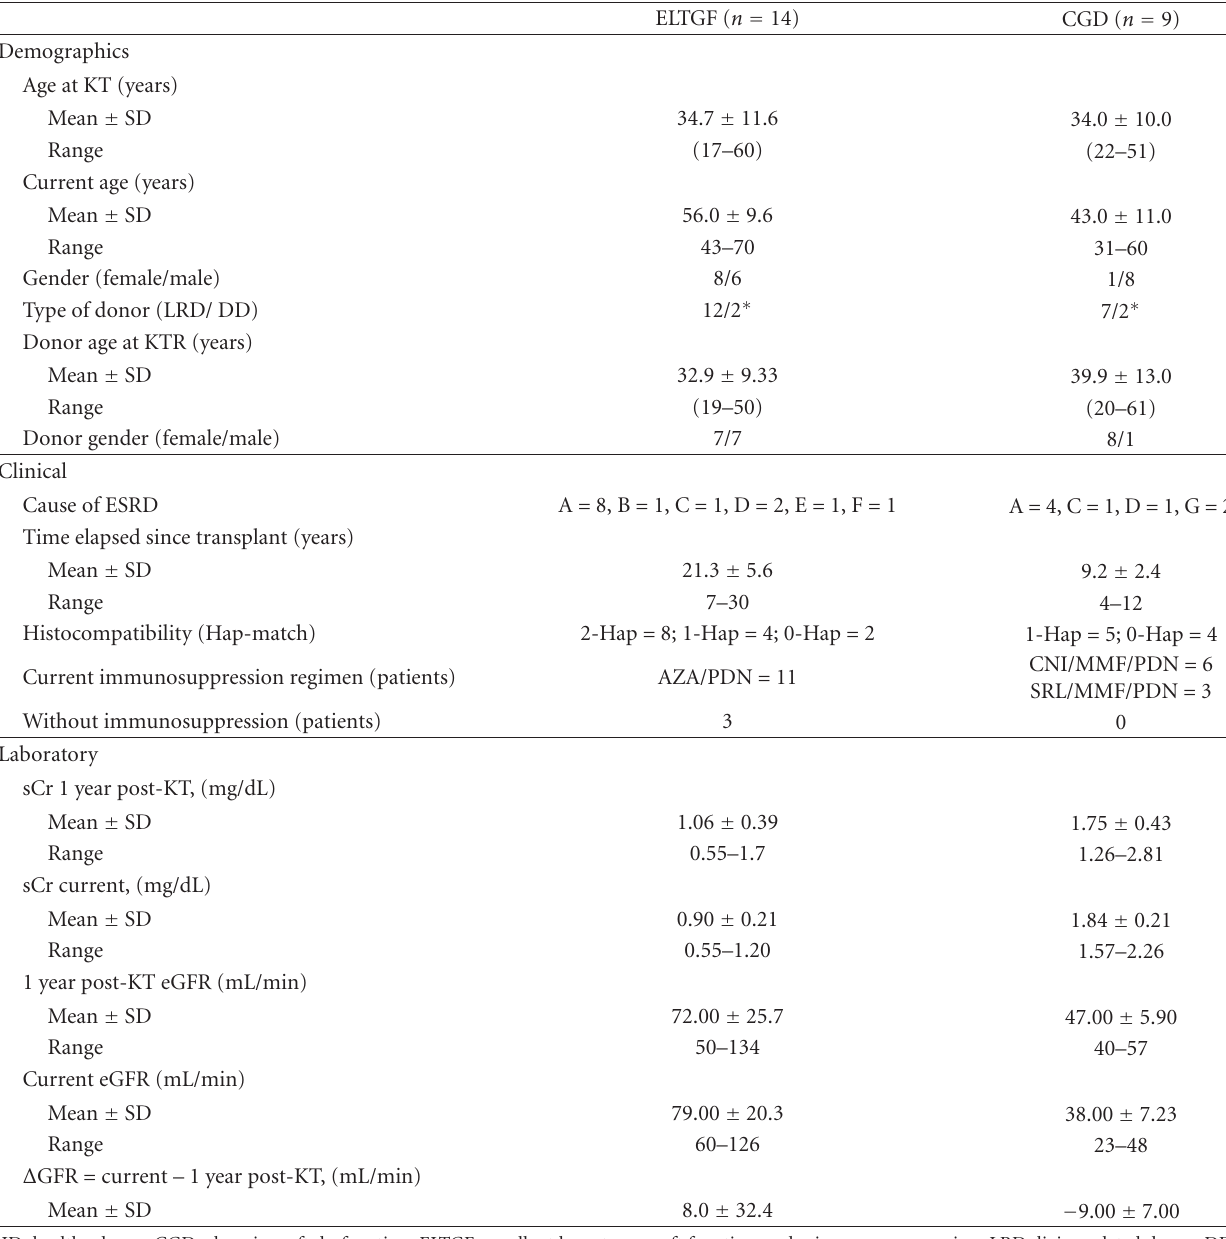
Table 1: Demographic and clinical data of kidney transplant